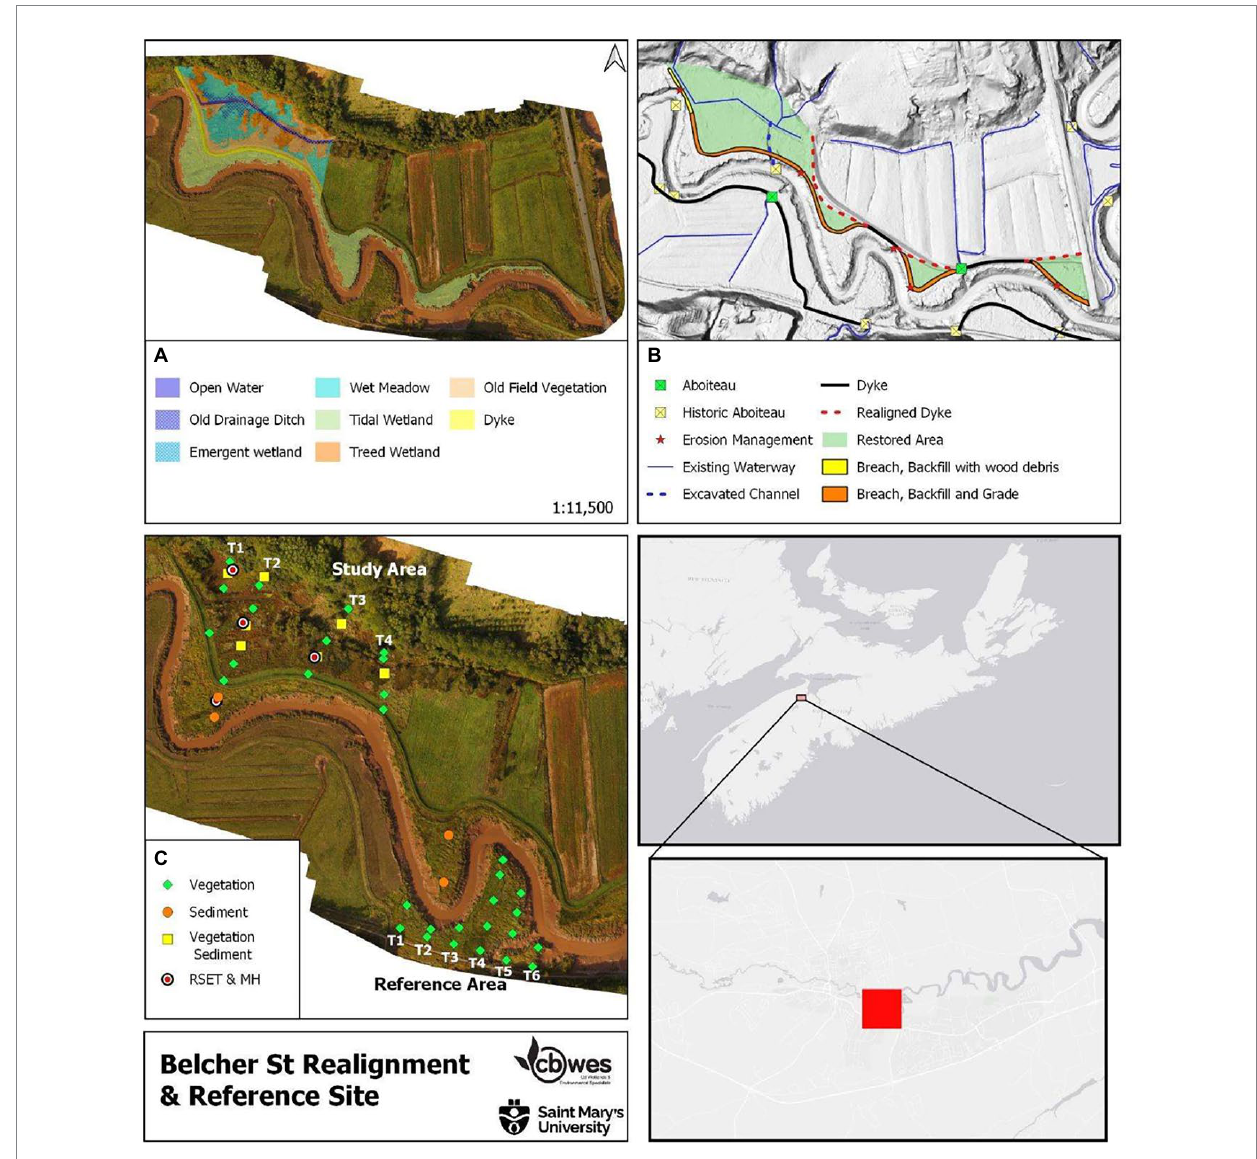
FIGURE 2 Belcher Street site (A) Pre-restoration habitat map; (B) Restoration plan; (C) Sampling